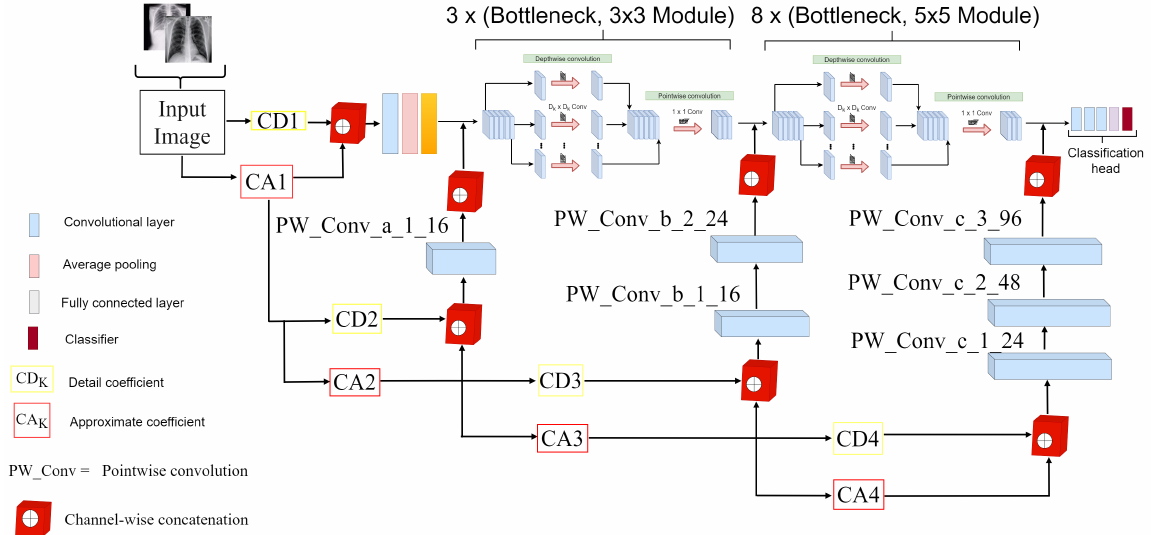
Figure 3. Overall structure of our proposed